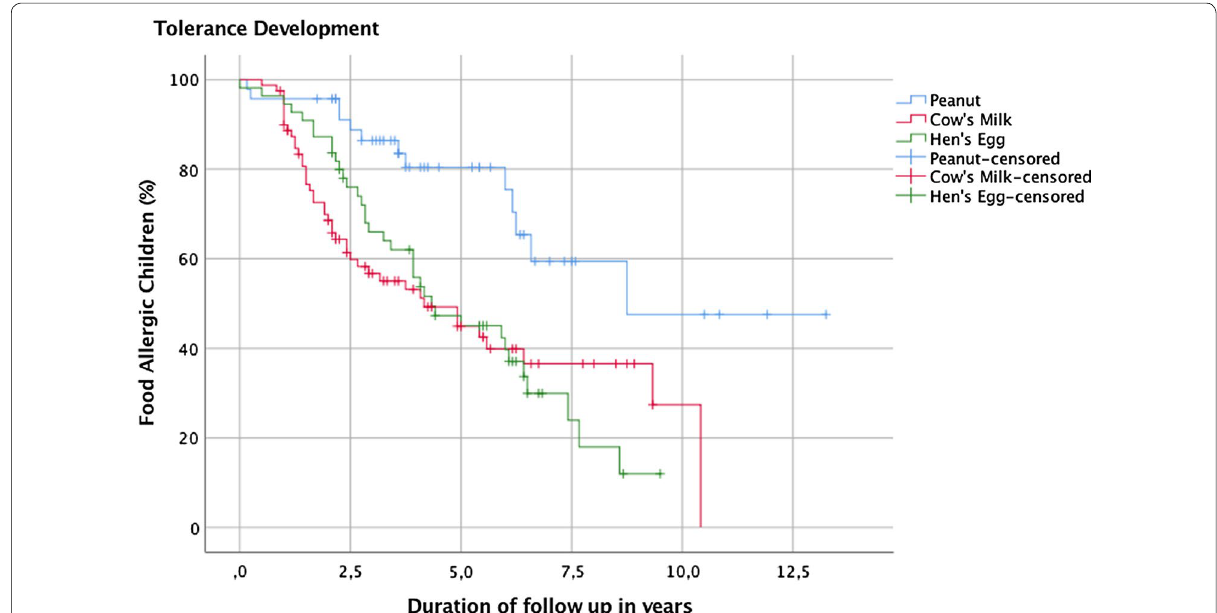
Fig. 2 Kaplan‑Meier survival curve in peanut, cow’s milk and hen’s egg allergic